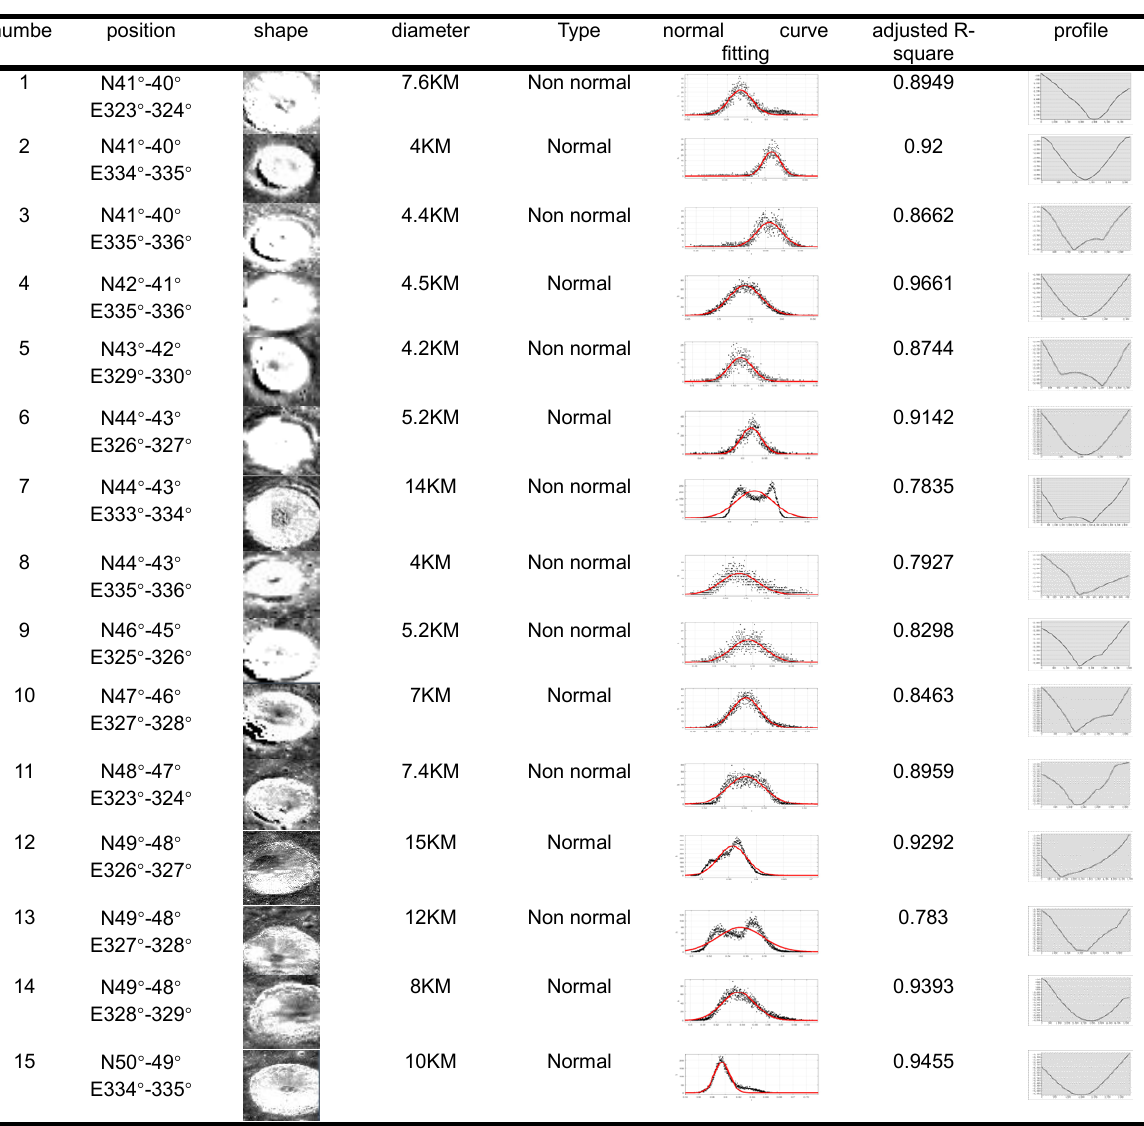
Table 4 . Statistical table of impact craters whose diameters are greater than